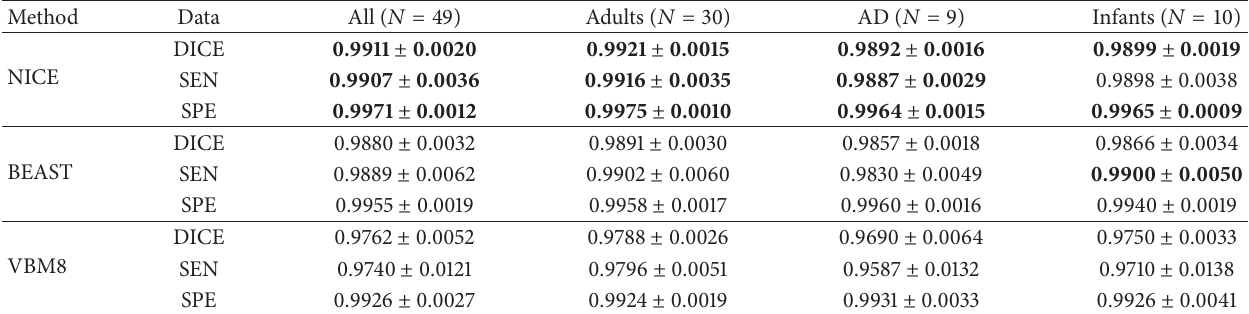
Table 1: Average DICE coefficient for the different methods compared on the different used datasets. The best results from each column are in bold.